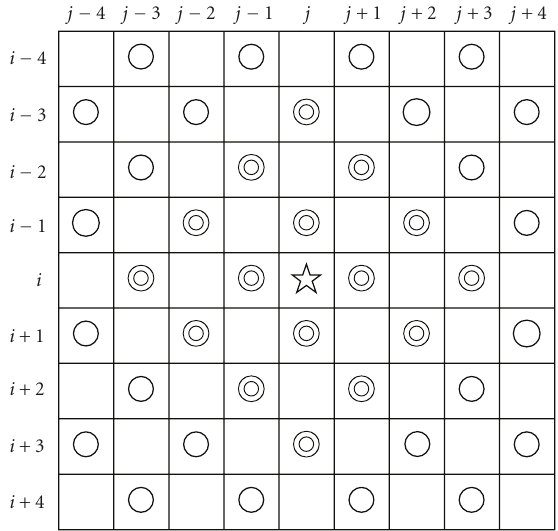
Figure 7: An illustration of the prediction algorithm: the pixel values at the position marked and are known, the pixels at the positions marked are used to predict the value of center pixel (marked ), and all other unmarked pixels will be predicted in the second prediction